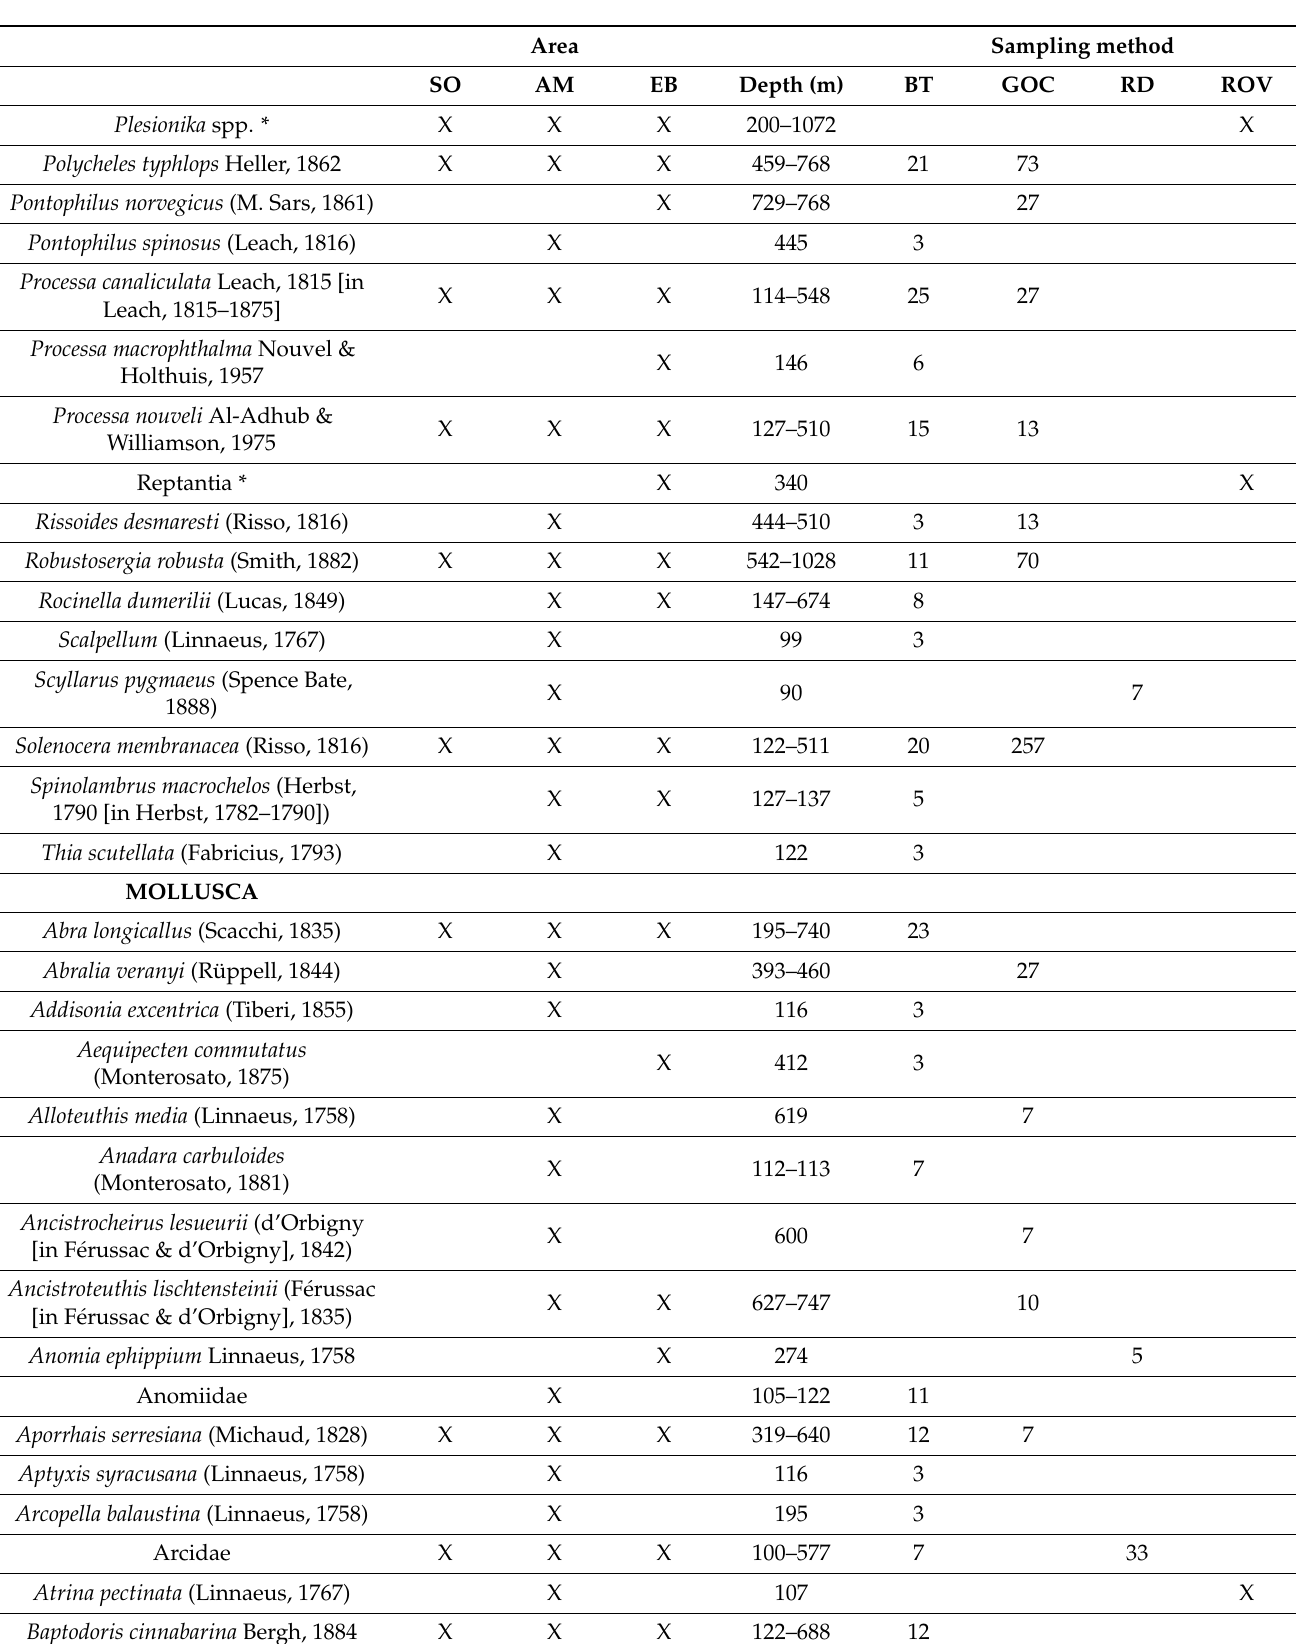
Table A7. Cont. Area Sampling